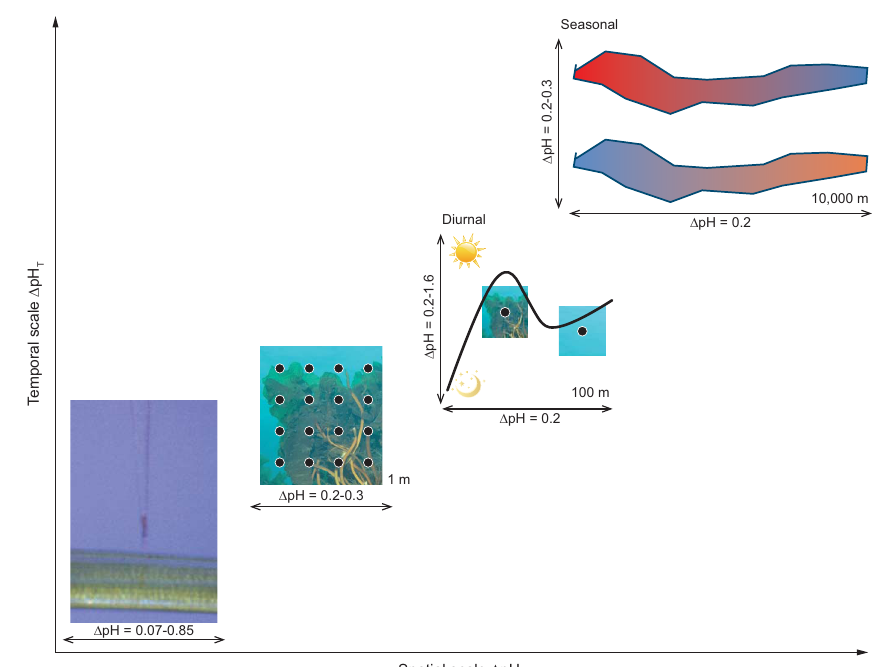
Figure 10. Conceptual summary of nested scales of temporal and spatial variability in pH in Kobbefjord, Nuuk. The figure shows the maxi- mum pH range at the various scales examined. From lower left to upper right: (1) microscale variability across macrophyte diffusive boundary layers, (2) small-scale variability within kelp forests, (3) diurnal variability in vegetated subtidal habitats and intertidal pools/adjacent shores and variability between habitats at the 100m scale, and (4) seasonal and fjord-scale horizontal